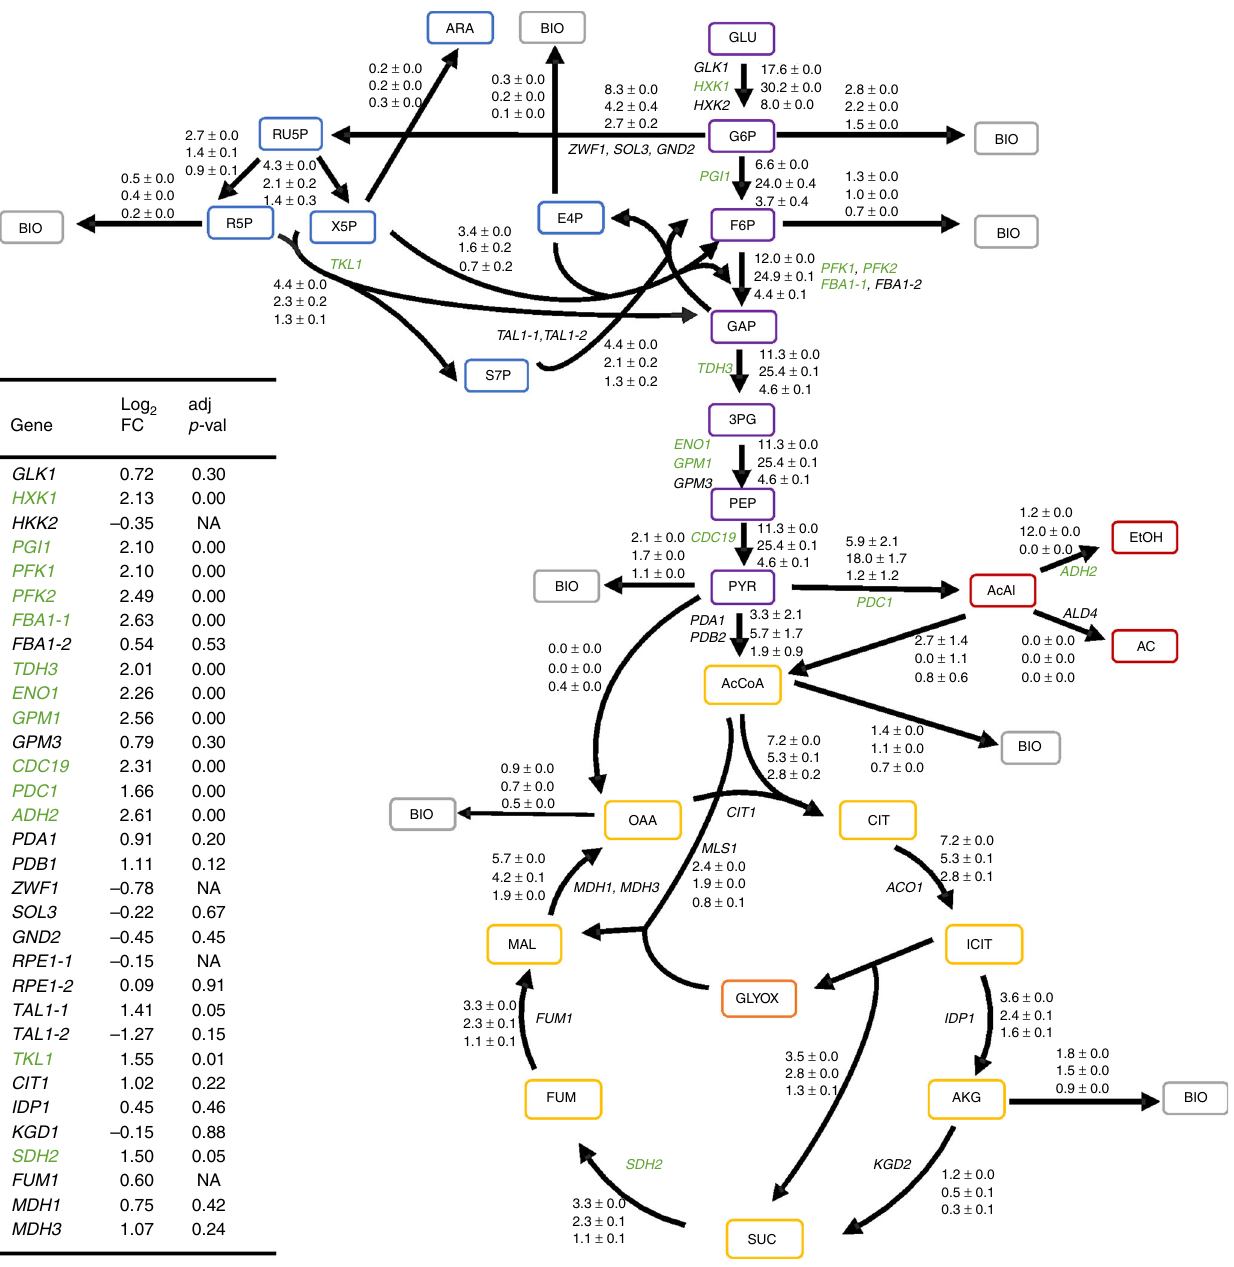
Fig. 5 13 C metabolic fl ux analysis and RNASeq explain the over fl ow metabolism. Glycolysis and fermentation correlate with pathway gene upregulation in the CRA1 overexpression strain. Absolute speci fi c fl ux rates per carbon atom (C-mmolg − 1 h − 1 ) of control, CRA1 overexpression and Δ cra1 strains are given from top to bottom. For reversible fl uxes, only net fl uxes are shown. Gene names of the corresponding reactions are colored green for transcriptionally upregulated, and black for unregulated genes in the CRA1 overexpression strain compared to the control. The insert table displays the respective log 2 fold changes and adjusted p -values. NA means data did not meet fi lter criteria for p -value calculation (see Methods). Mean values of triplicate experiments for the control, overexpression and knock-out K. phaf fi i strains are presented. ± represents the standard deviation. Values of each reaction refer to the total number of carbon atoms involved in this reaction. For clarity of the fi gure, fl uxes to CO 2 are not